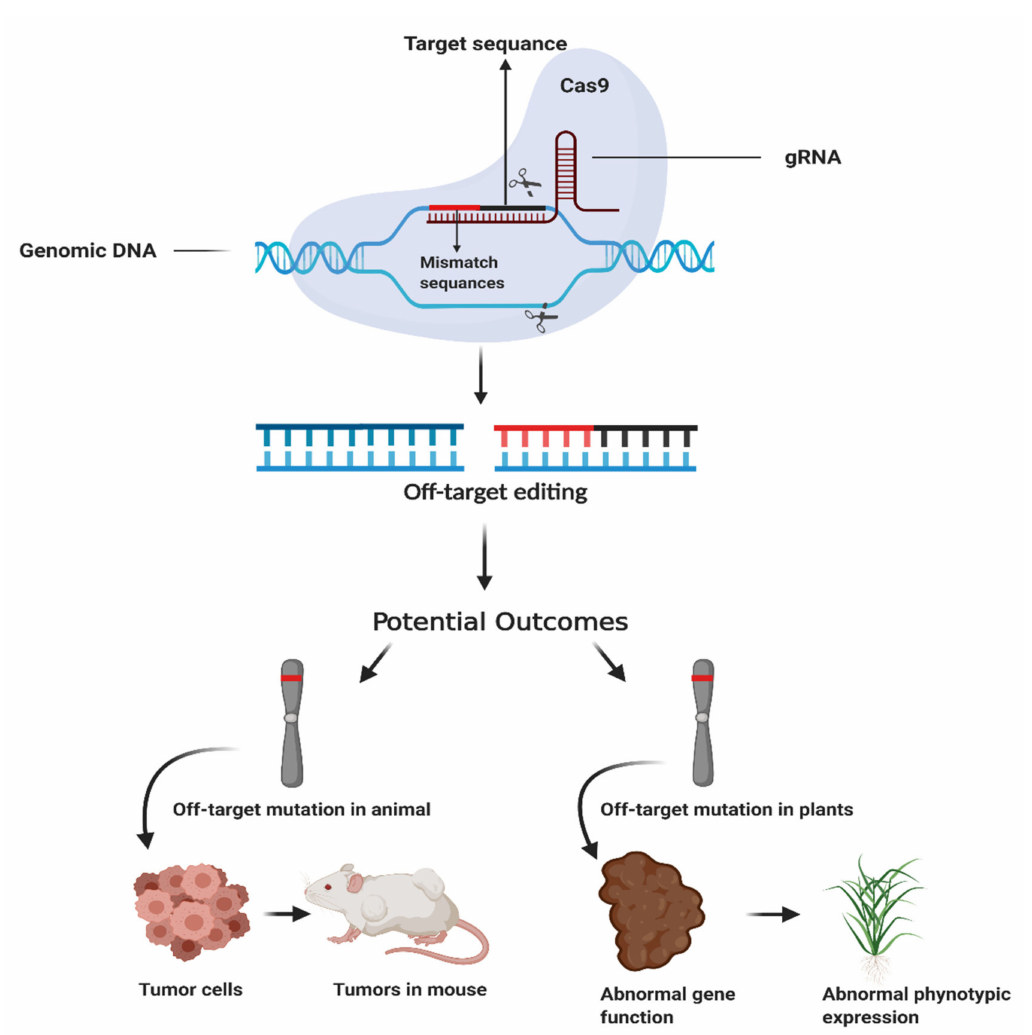
Figure 1. E ff ects of o ff -target mutation on animal and plant phenotype. O ff -target causes genetic mutations. In clustered regularly interspaced short palindromic repeats (CRISPR) / Cas9 system gRNA sometimes binds other than target loci, o ff -target site. It may activate the oncogenes that initiate tumor cell formation in the animal body or may change gene function that leads to undesirable phenotypic expression (sensitive to diseases) in plants. The figure has been created with